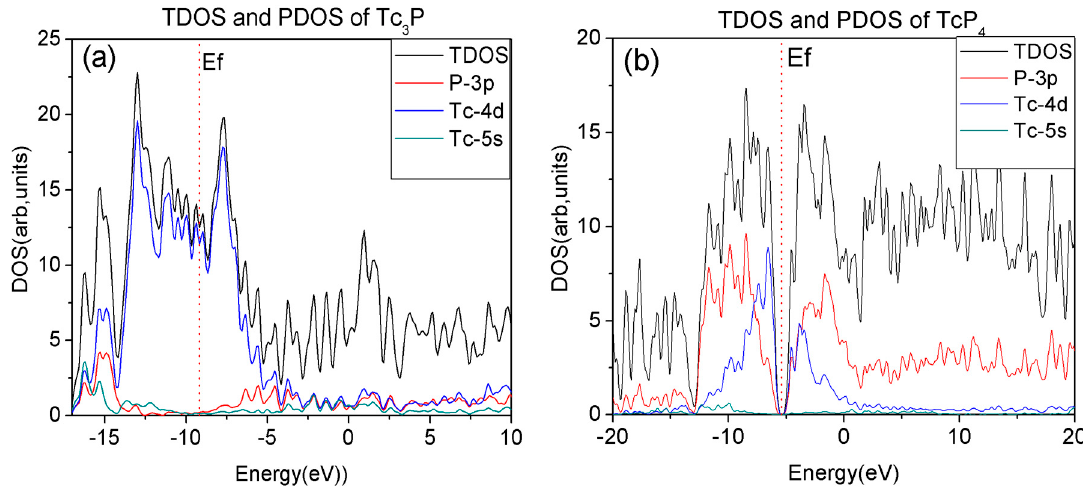
Figure 2. The total density of states (DOS) and projected DOS (PDOS) of P(3p), Tc(4d) and Tc(5s) for ( a ) Tc 3 P crystal in the range from − 16 to 10 eV and ( b ) TcP 4 crystal in the range from − 20 to 20 eV. The red vertical dotted lines correspond to the Fermi level E f .